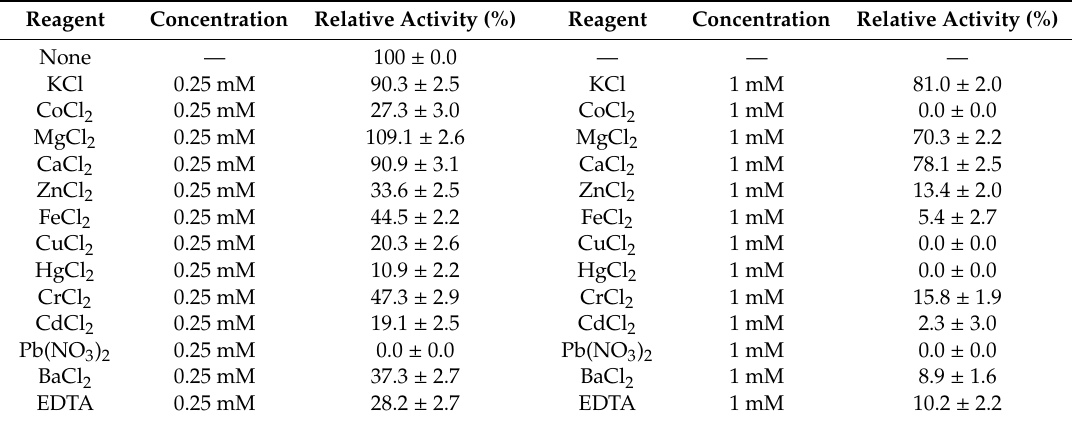
Table 4. E ff ects of di ff erent reagents on the rPsGR